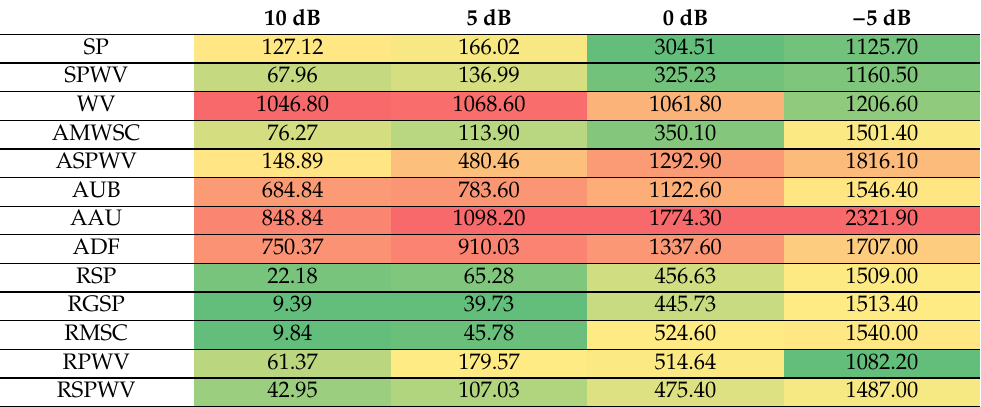
Table 5. Estimation of IF MSE for a noisy multi-component signal with successive parabolic and linear FM components for different SNR levels (averaged over 100 noise realizations), cell colors range from green for the best result to red for the worst result in each column respectively, 1 × 10 − 5 . 10 dB